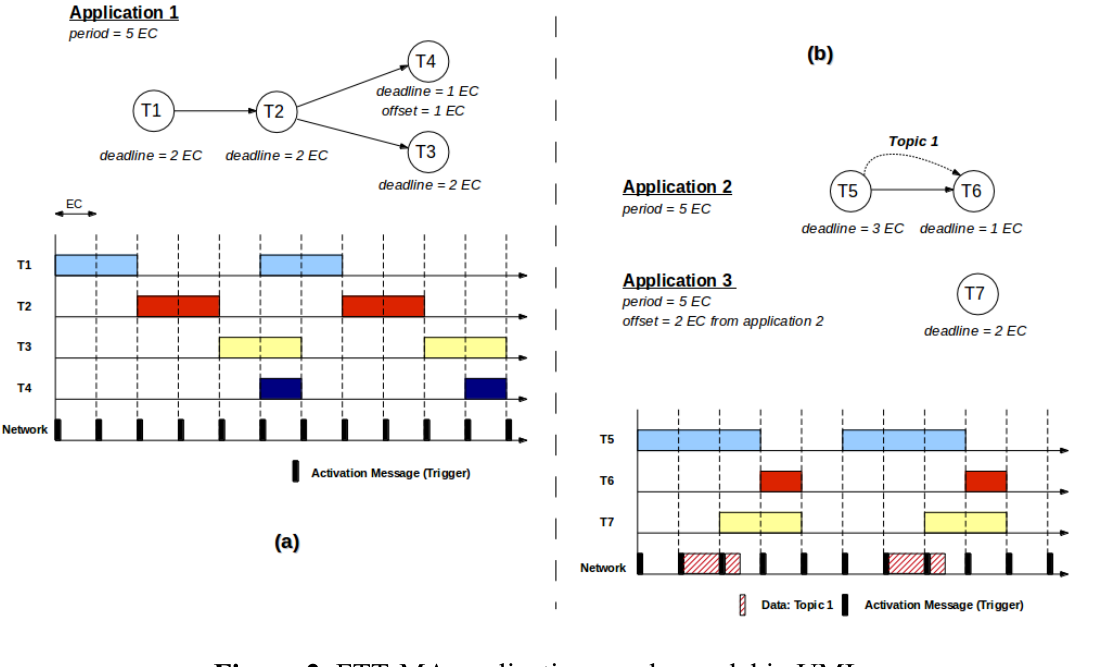
Figure 2. FTT-MA application graphs model in